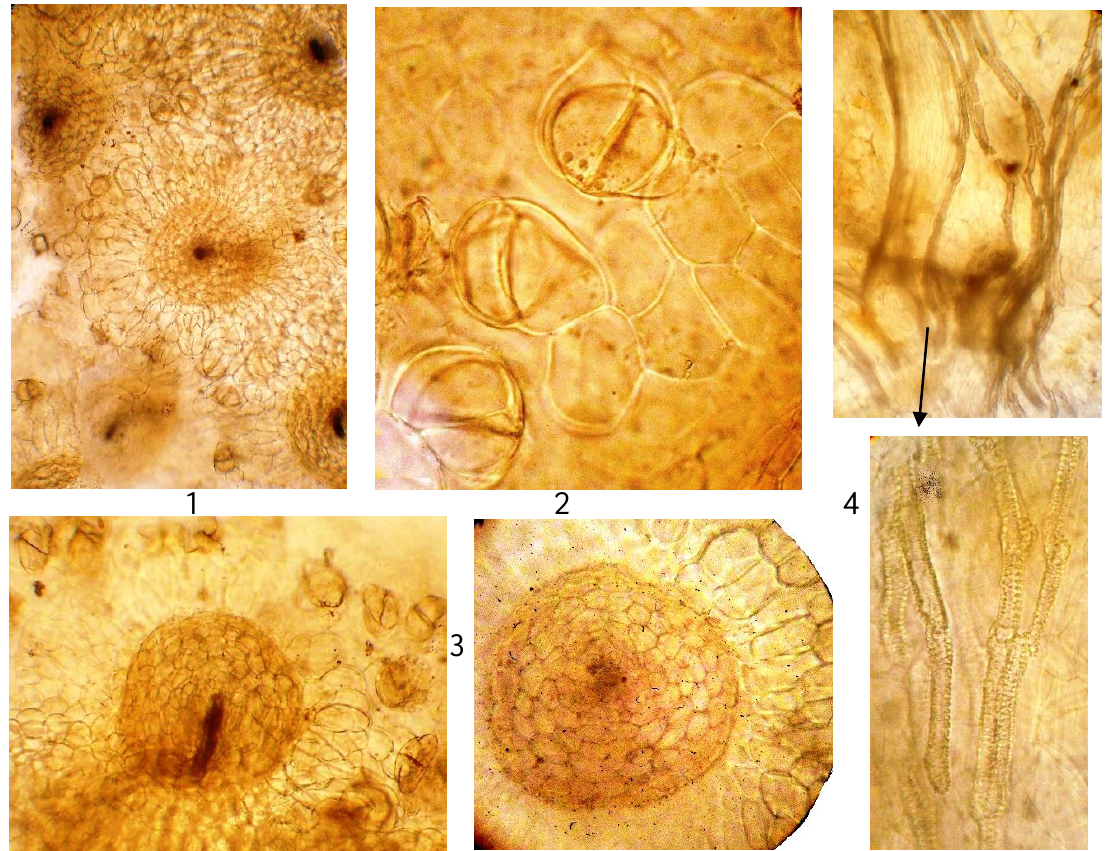
Fig. 6. Fragments of surface preparations of anthodium wrapper leaves: 1 – general view of the upper epidermis; 2 – epidermis with essential oil glands; 3 – multicellular emergencies; 4 –